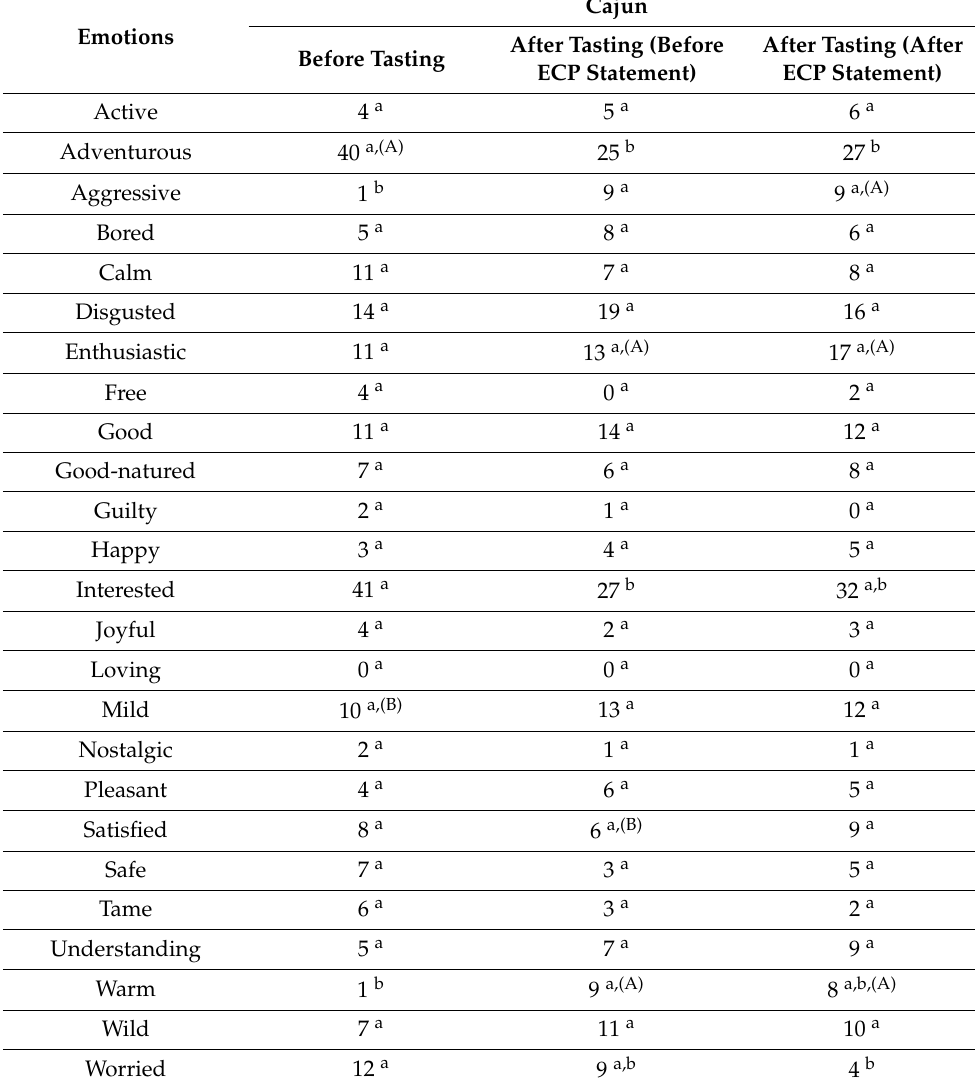
Table 6. Emotional profile † elicited by the Cajun treatment ‡ across